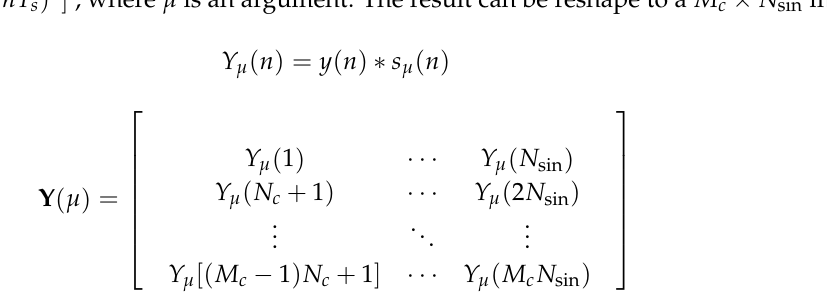
Figure 2. Time-frequency diagram of a sampled linear frequency modulated (LFM) signal.